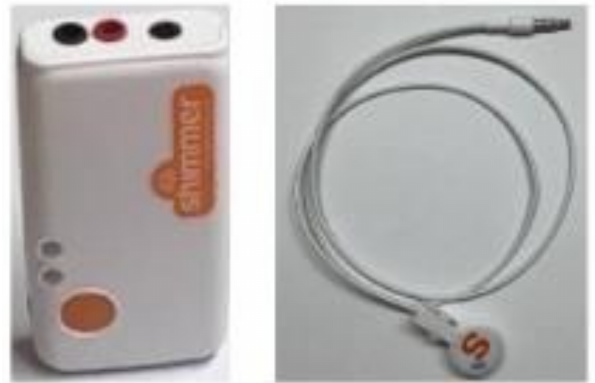
Figure 6. SHIMMER3 GSR+ Unit SR48-3-0 and SHIMMER PPG optical pulse clip for PPG